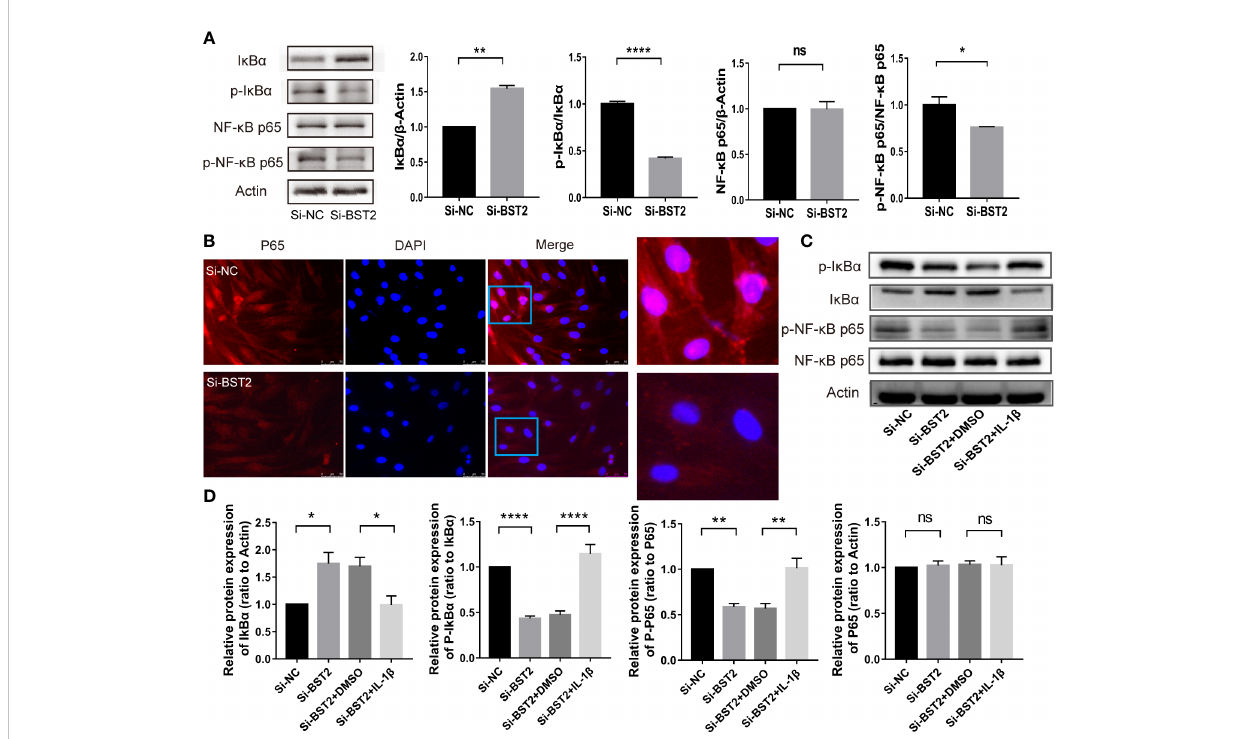
FIGURE 6 BST2 activated the NF- k B signaling pathway. (A) , The expressions of key proteins of NF- k B pathway were measured by western blot analysis after transfection with Si-BST2 or Si-NC for 48h. (B) , The Representative images of Immuno fl uorescence showed the cellular localization of NF- k B p65 protein in EESCs after transfection with Si-BST2 or Si-NC for 48h. (C, D) , The protein expressions of NF- k B pathway were measured by western blot analysis after treatment with Si-BST2 or Si-NC or/and the NF- k B pathway activator IL-1 b . ns, p ≥ 0.05; *p < 0.05; **p < 0.01; ****p <